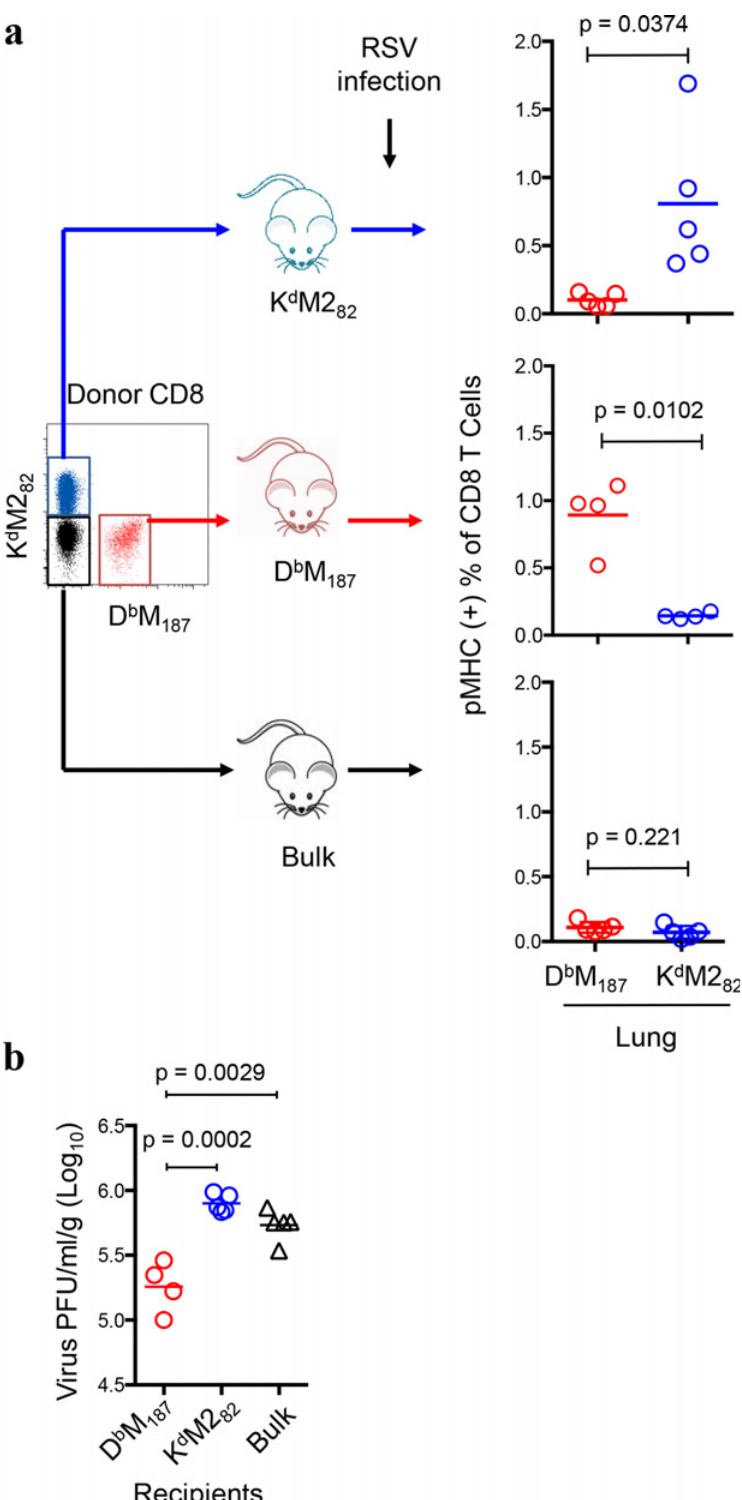
Fig 7. The D b M 187 T cells efficiently control viral replication. (a) Adoptive transfer of pMHC-specific donor cells increases precursor of CD8 T effector cells during early infection. Live D b M 187 , K d M2 82 and bulk (with neither specificity) CD8 T cells from spleen lymphocytes of RSV-infected mice at 7dpi were sorted with